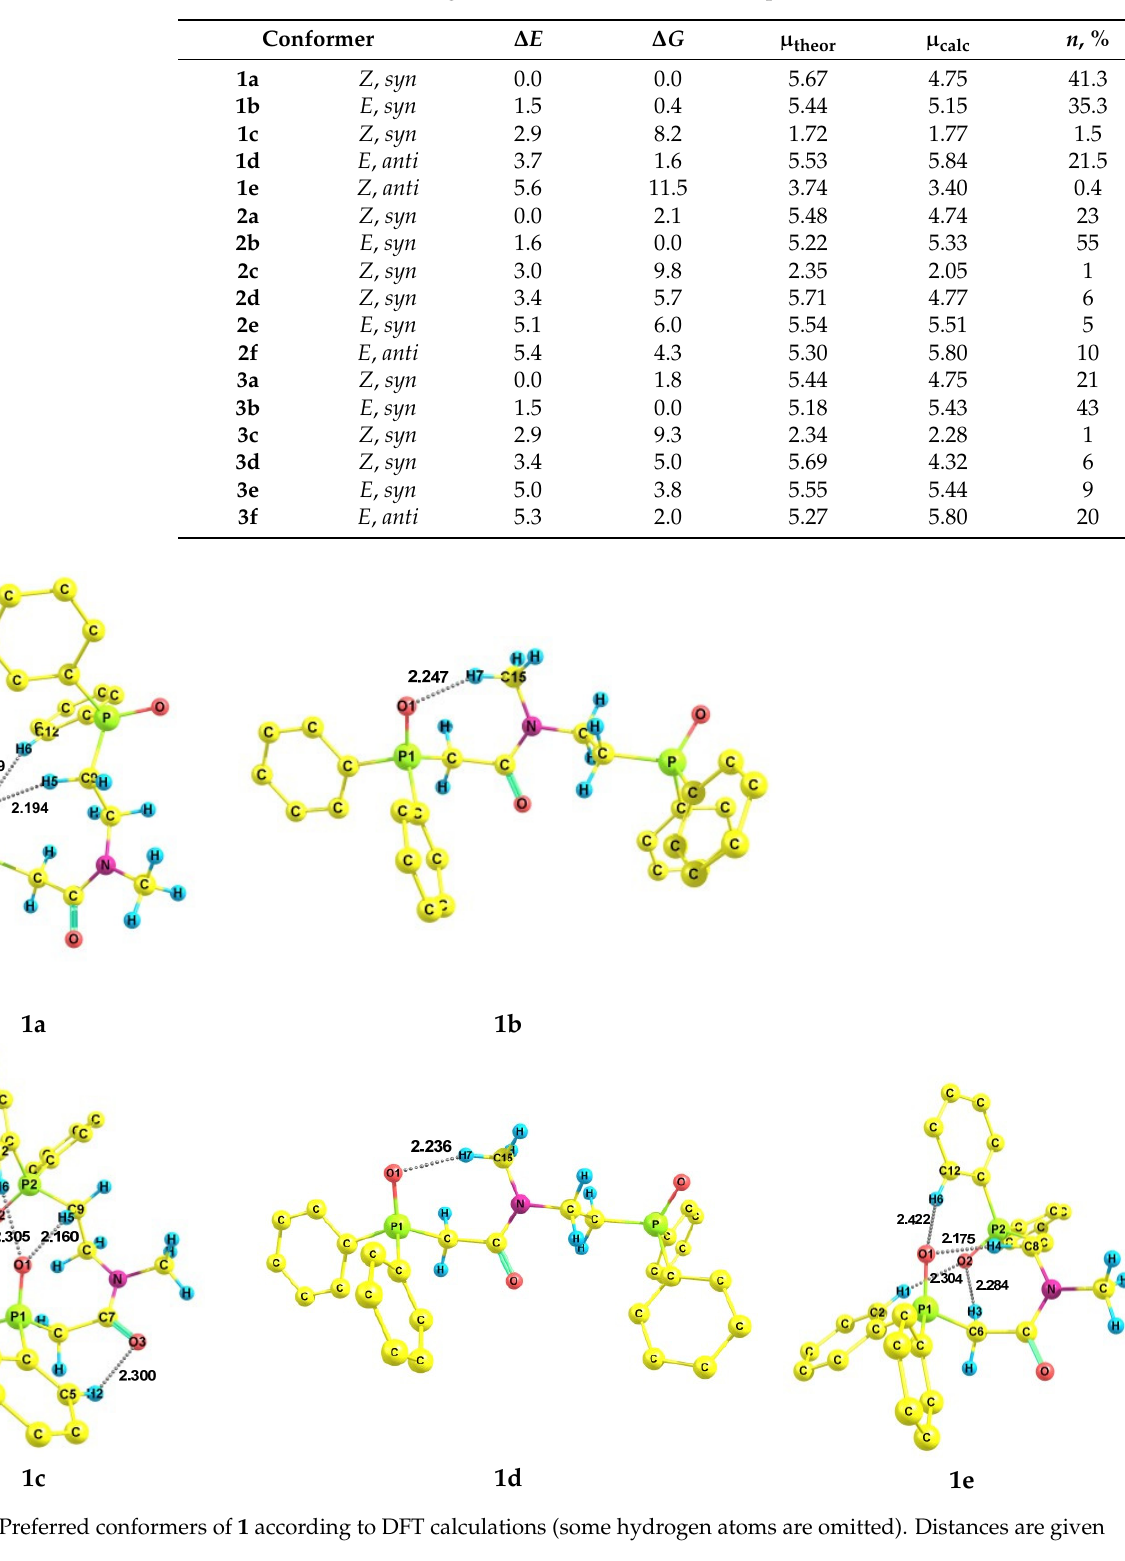
Table 2. Relative energies ( ∆ E) , Gibbs free energies ( ∆ G , 298.15 K ) (kJ/mol), theoretical ( µ theor) and calculated by the vector-additive scheme ( µ calc) ) dipole moments (D), percentage ( n ) of preferred